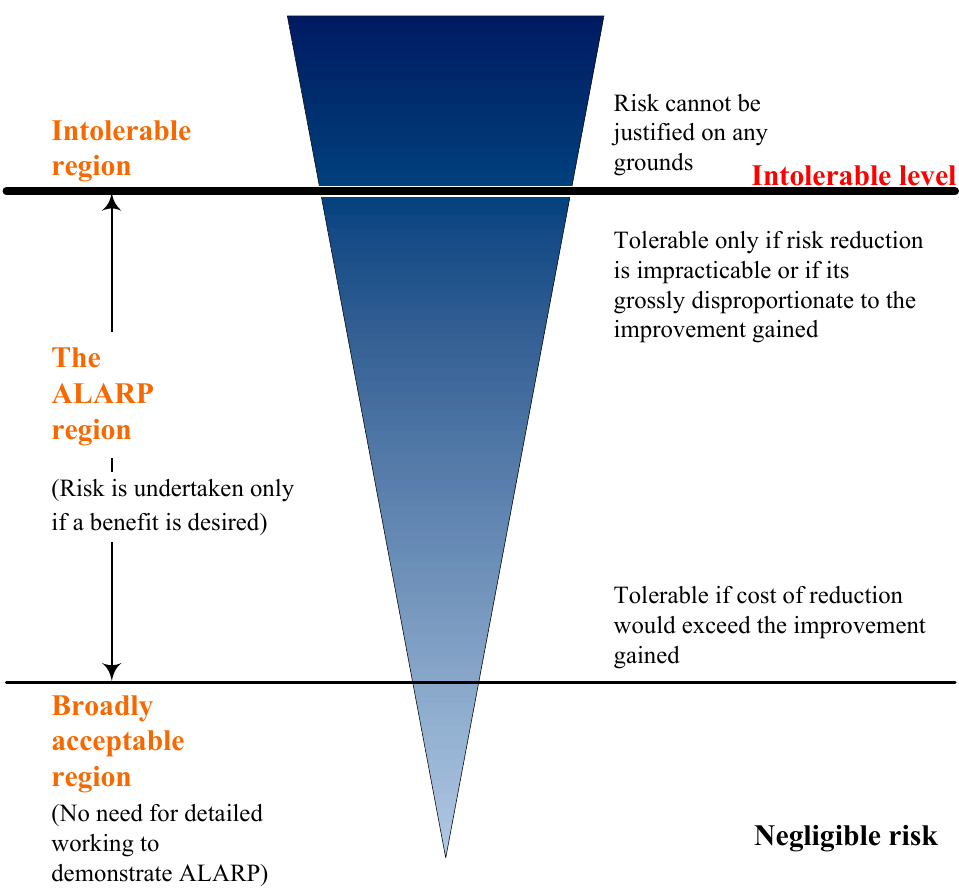
Figure 7. Levels of risk and ALARP [35,37].